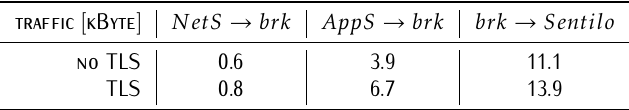
Table 4. Traffic intensity. Bytes exchanged at each link for one node observation